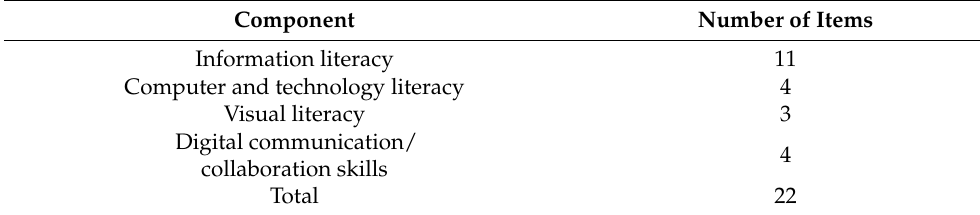
Table 1. Initial component of digital skills instrument (DSI). Component Number of Items